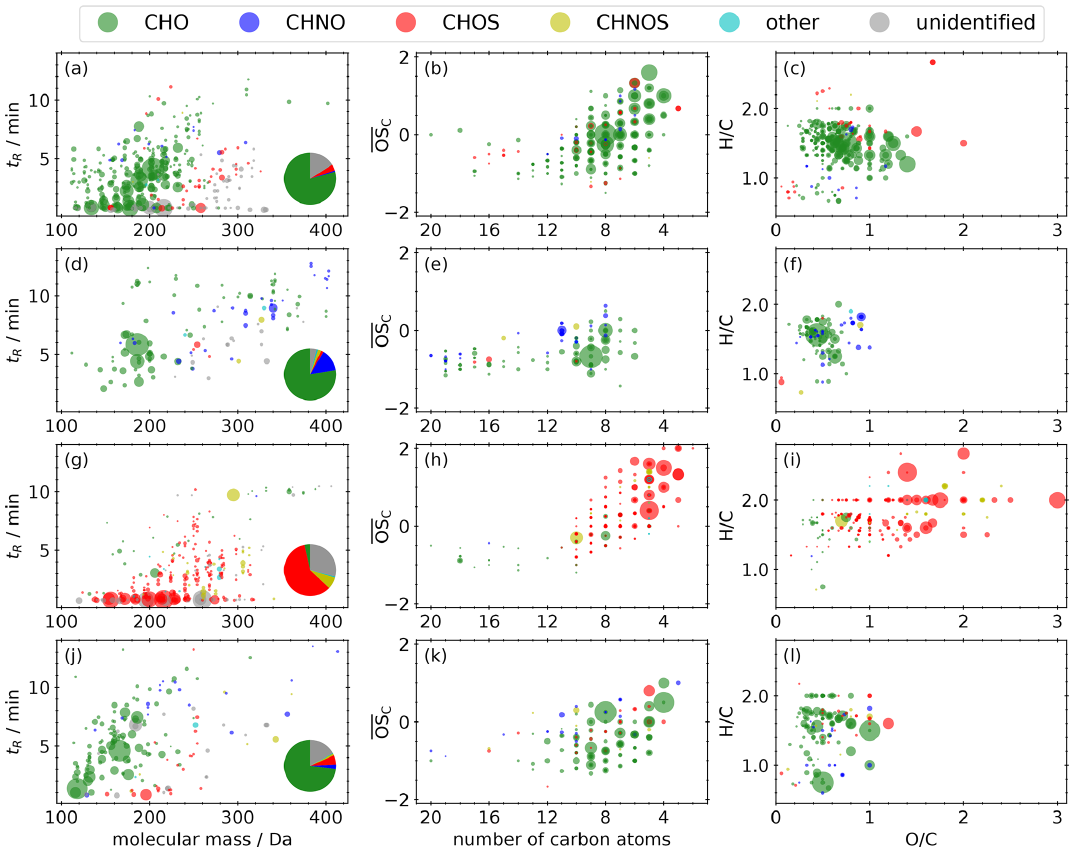
Figure 7. Molecular fingerprint of compounds that appear in compound clusters I (a–c) , II (d–f) , III (g–i) , and IV (j–l) , illustrated as retention time vs. molecular mass, Kroll diagram, and van Krevelen diagram. The area of the scatters represents the mean signal intensity on a linear scale. The pie chart shows the proportions of the different molecular formula